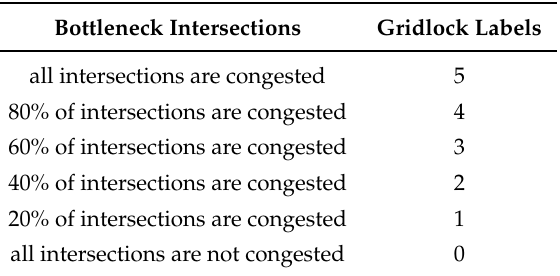
Figure 5. Gridlock-looped intersections in the Sathorn area. Table 1. Gridlock